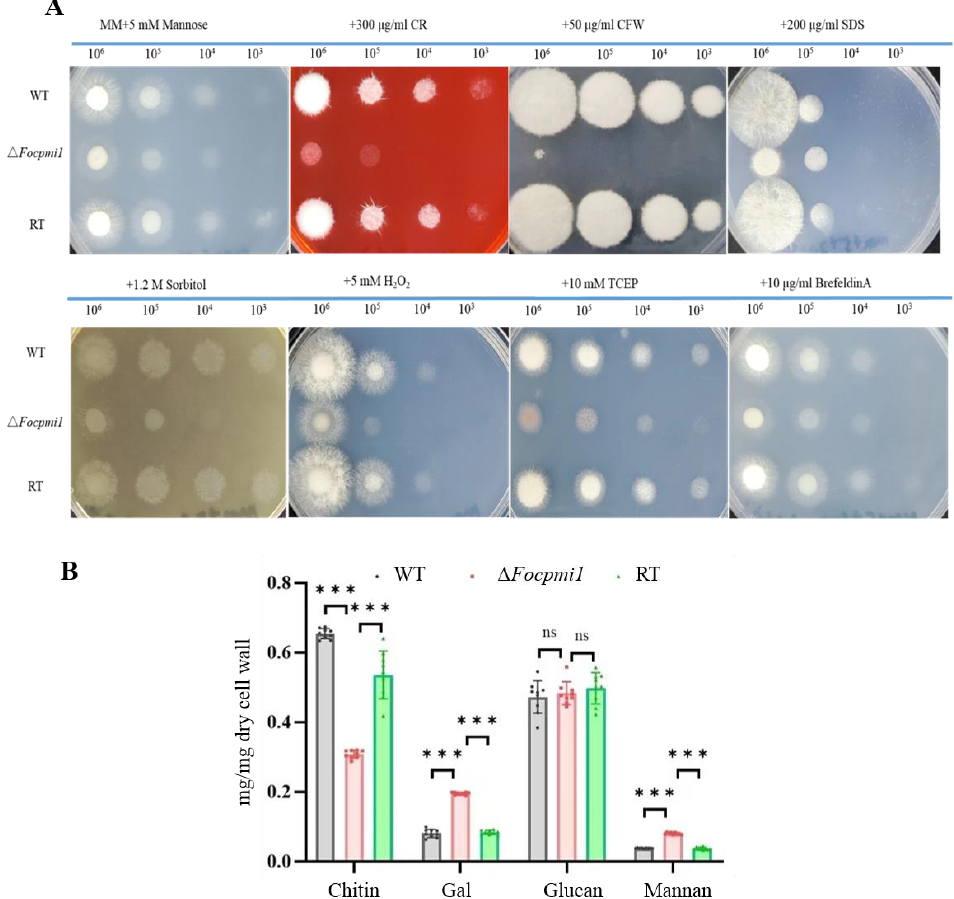
Figure 4. Cell wall integrity, content analysis, and sensitivity of the mutant towards osmotic, oxidative, and ER stresses. ( A ) Freshly harvested serially diluted conidia (10 6 –10 3 ) were point inoculated onto MMM plates supplemented with 300 µ g/mL CR, 50 µ g/mL CFW, 200 µ g/mL SDS, 1.2 M sorbitol, 5 mM H 2 O 2 , 10 mM TCEP, and 10 µ g/mL Brefeldin A. The plates were photographed after 48 h of incubation at 28 ◦ C. ( B ) A total of 2 × 10 8 conidia of the WT, ∆ Focpmi1 , and RT strains were inoculated in MMM liquid medium and incubated at 28 ◦ C for 72 h. Dried mycelia (10 mg) were used for the cell wall contents’ quantification. The experiment was conducted in three biological replicates. Asterisks indicate significant differences (Student’s t -test, *** p < 0.001).